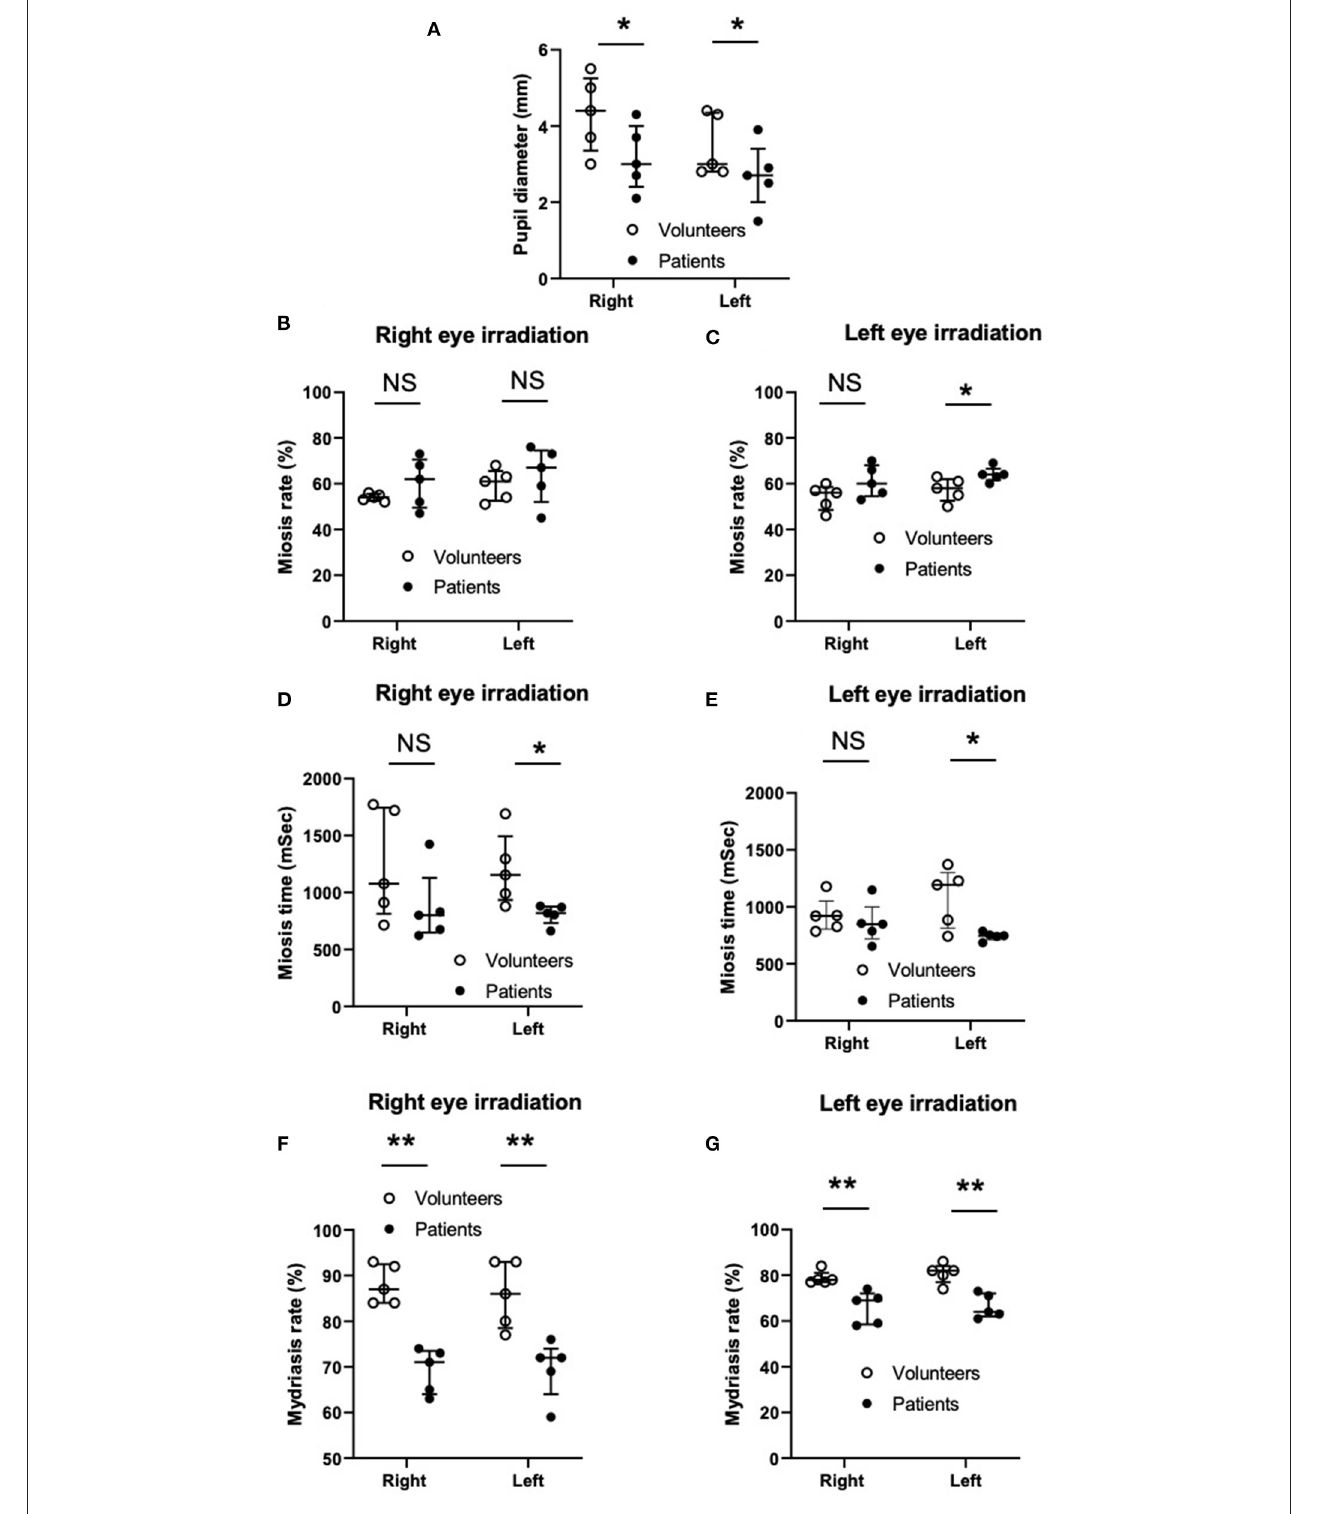
FIGURE 6 | Comparison of spontaneous pupil diameters (A) , miosis rate (B,C) , miosis time (D,E) , and mydriasis rate (F,G) between the volunteers and patients. Column scatter plots representing the data distribution (open and closed circles), median (horizontal bar), and interquartile range (vertical bar). NS, not significant. ** P < 0.01, * P < 0.05. N = 5 in each